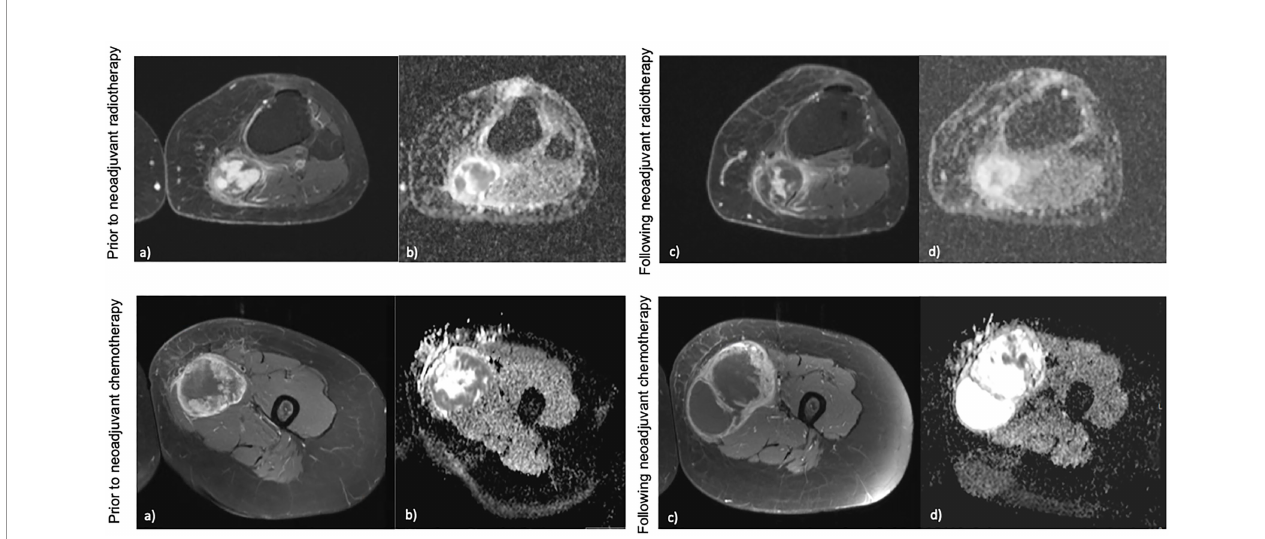
FIGURE 2 | Examples of different radiological response following neoadjuvant therapy. Top: (A, B) demonstrate a hisloJogically con fi rmed myxo fi brosarcoma in the calf prior to neoadjuvant radiotherapy on post-contrast imaging and ADC maps, (C, D) demonstrate the mass following neoadjuvant radiotherapy which shows no change in overall size, however a change in contrast signal and ADC can be seen. This would he stable by RECIST 1.1. Bottom: (A, B) demonstrate a biopsy con fi rmed ewing's sarcoma of the thigh prior to neoadjuvant chemotherapy on post-contrast imaging and ADC maps, (C, D) demonstrate the mass following neoadjuvant chemotherapy which has increased in size, however a change in ihe contrast signal and ADC within the mass can be seen. This mass would be measured as progression by RECIST 1.1